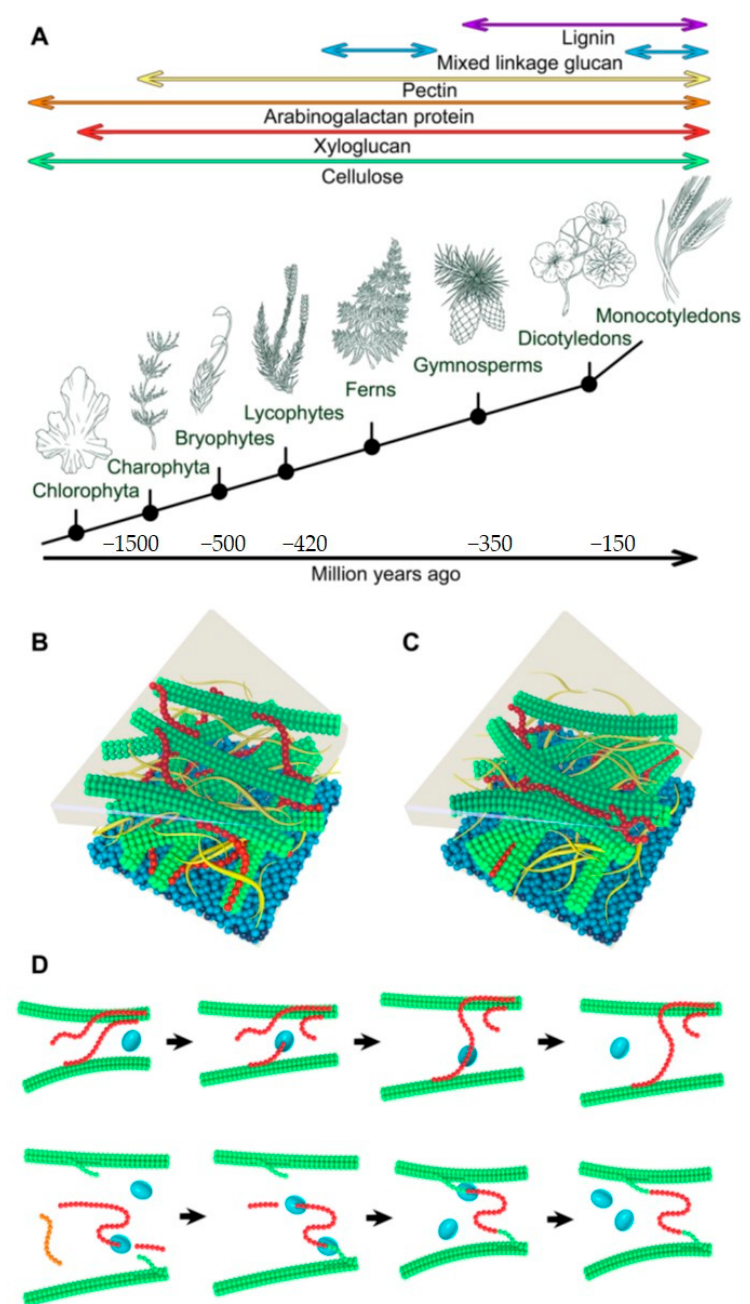
Figure 1. Polysaccharides form the structural foundation of plant CWs. ( A ) distinct polysaccharides emerge in plant CWs in phyla during the evolutionary history of plants [22,55]; ( B , C ) intuitive CW structural models by Albersheim et al. [56] ( B ), and Park and Cosgrove [57] ( C ); ( D ) mechanisms of action of XET enzymes leading to the loosening of CWs through homo-transglycosylation reactions (top panel) [1], and cross-linking cellulose and XGs through hetero-transglycosylation reactions (bottom panel) that could enhance tighter packing of cellulose micro-fibrils and other polysaccharides [58]. Cellulose micro-fibrils are in green and XGs in red in ( B – D ); pectins are in yellow in ( B , C ); XETs are in cyan in ( D ); the plasma membrane is in blue in ( B , C